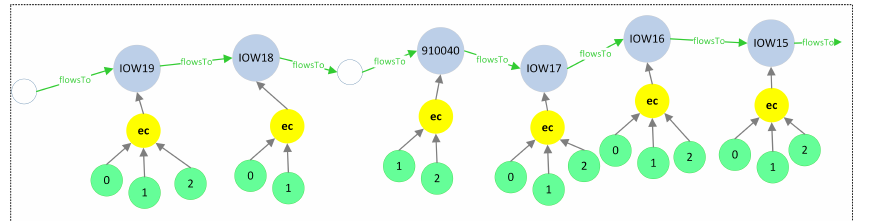
Figure 16. Neo4j Graph using the categorization based on global thresholds.